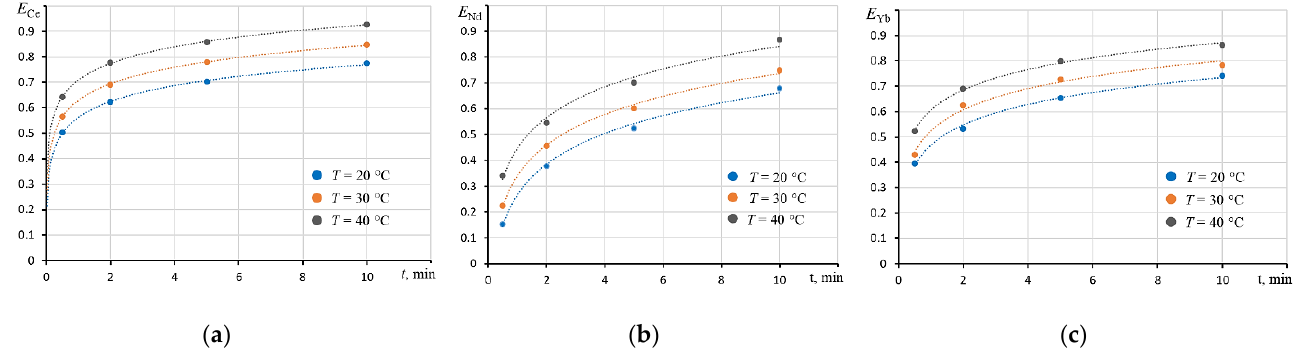
Figure 3. Lanthanide recovery rate versus mixing rate at a phase contact time of 10 min.